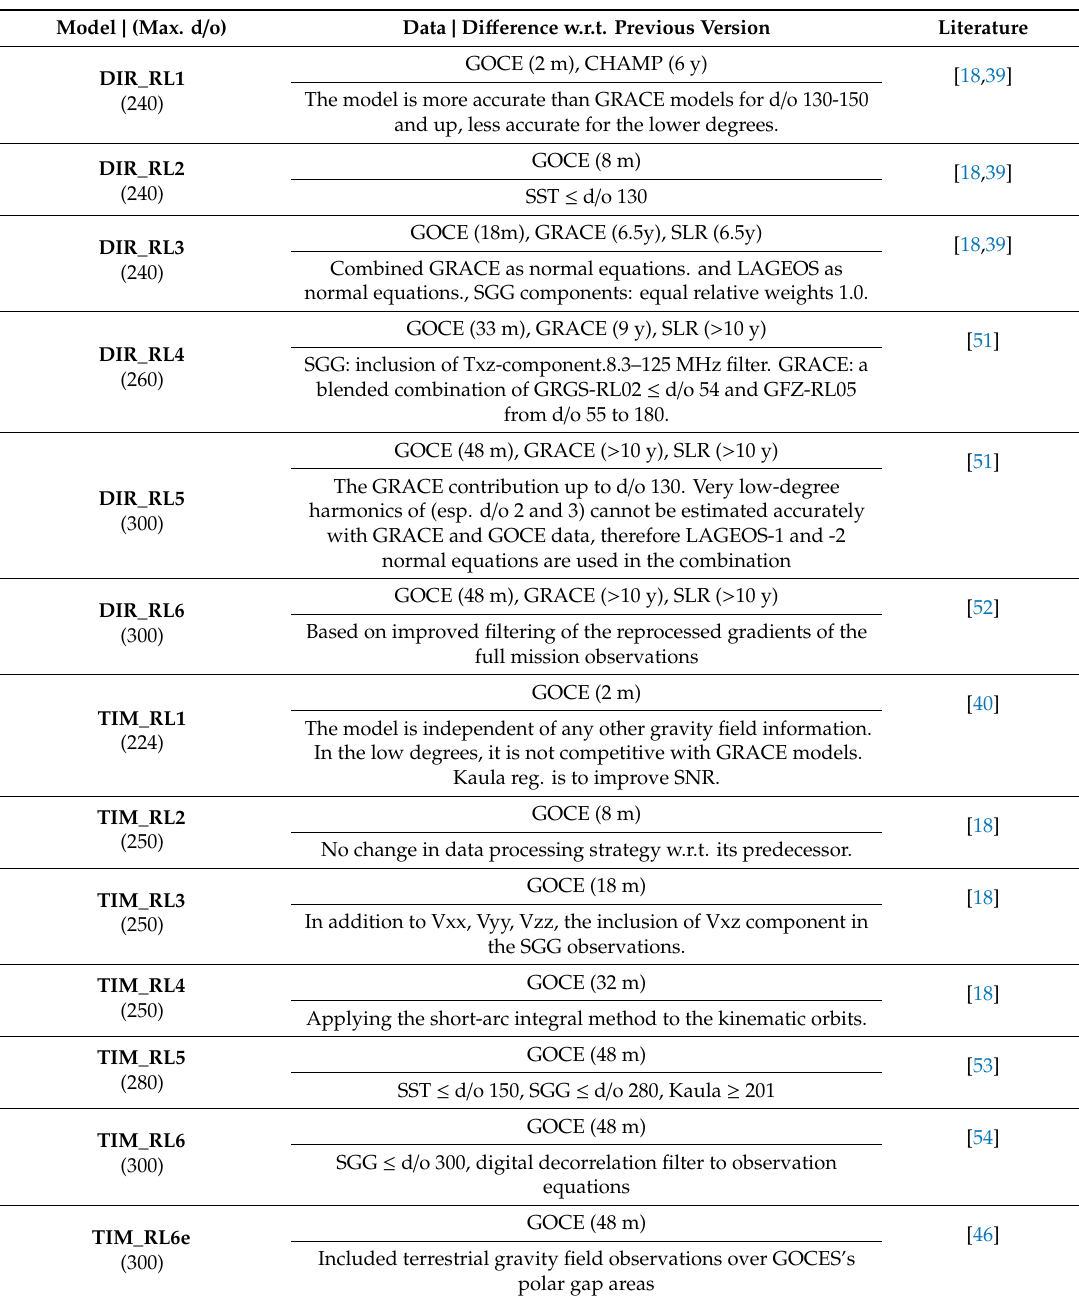
Table 1. Description of direct (GO_CONS_GCF_2_DIR), time-wise (_TIM), space-wise (_SPW) in addition to GOCO05S, GOGRA04S and EGM2008 models (data contents in m: month, y: year) [21,50]. Model | (Max. d /